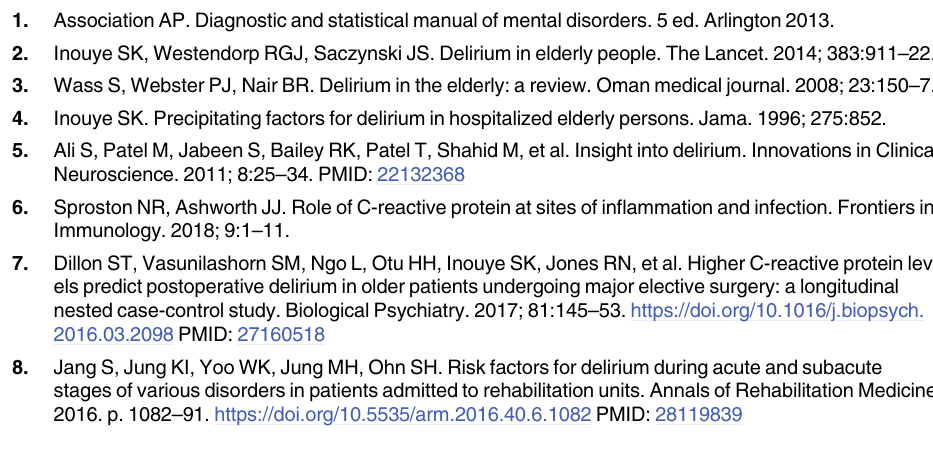
S1 Table. Results of final LME model on DRS-R-98 score. S2 Table. Results of final LME model on DRS-R-98 symptom scores. S3 Table. Results of final LME model on MMSE scores. S4 Table. R-squared values for the final